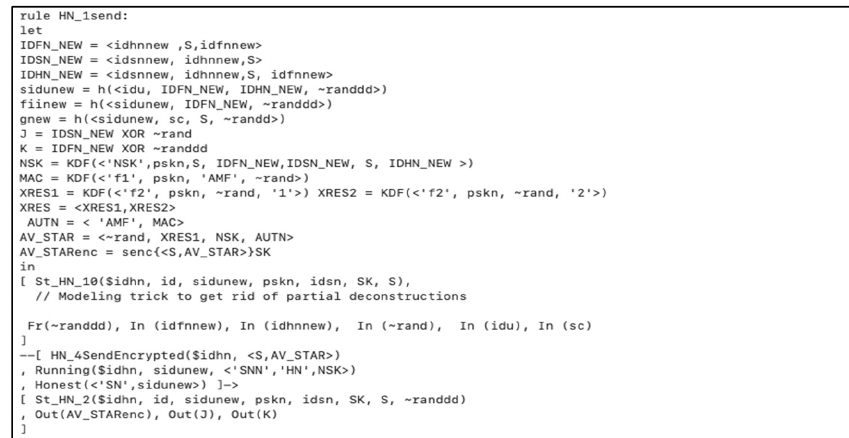
Figure 9. FN new parameters calculation and honesty verification. We specified some lemmas to ensure our parameters and nodes secrecy in a matter of session hijacking and guarantee that our scheme holds perfect forward secrecy, as depicted in Figure 10. Figure 10. Session hijacking and perfect forward secrecy resistance lemmas in HN and FN . Also, we specified other lemmas to prove our scheme parameters secrecy against replay attack, as depicted in Figure 11.